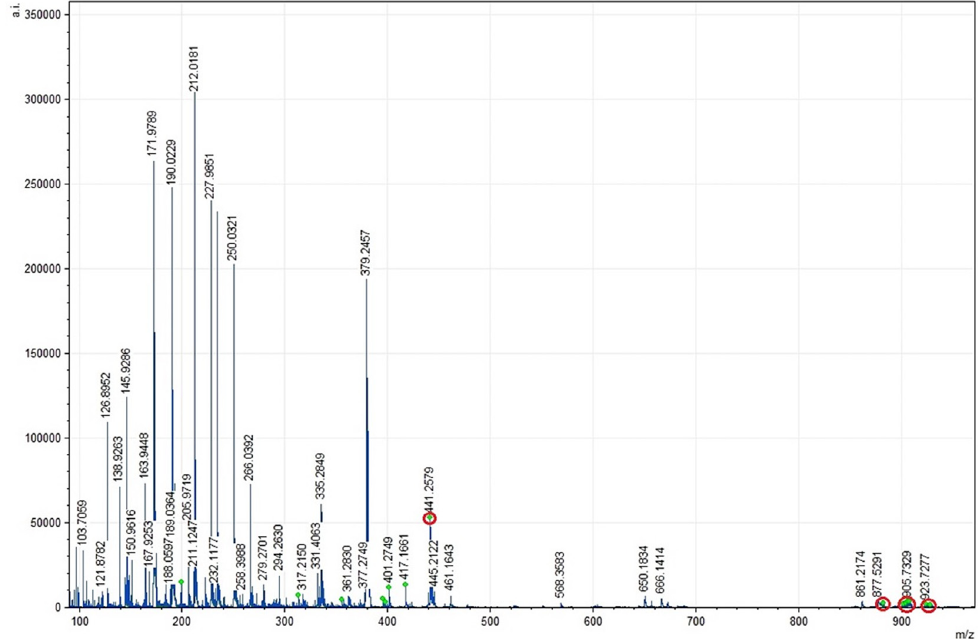
Figure 5. MALDI-TOF mMass report spectrum resulting from SAcyl obtained between 100 and 900 m / z ratio values. The m / z ratio signals corresponding to MG, DG, and TG presenting EPA/DHA at the sn -2 position are marked in red. Database: LIPID MAPS for glycerolipids.